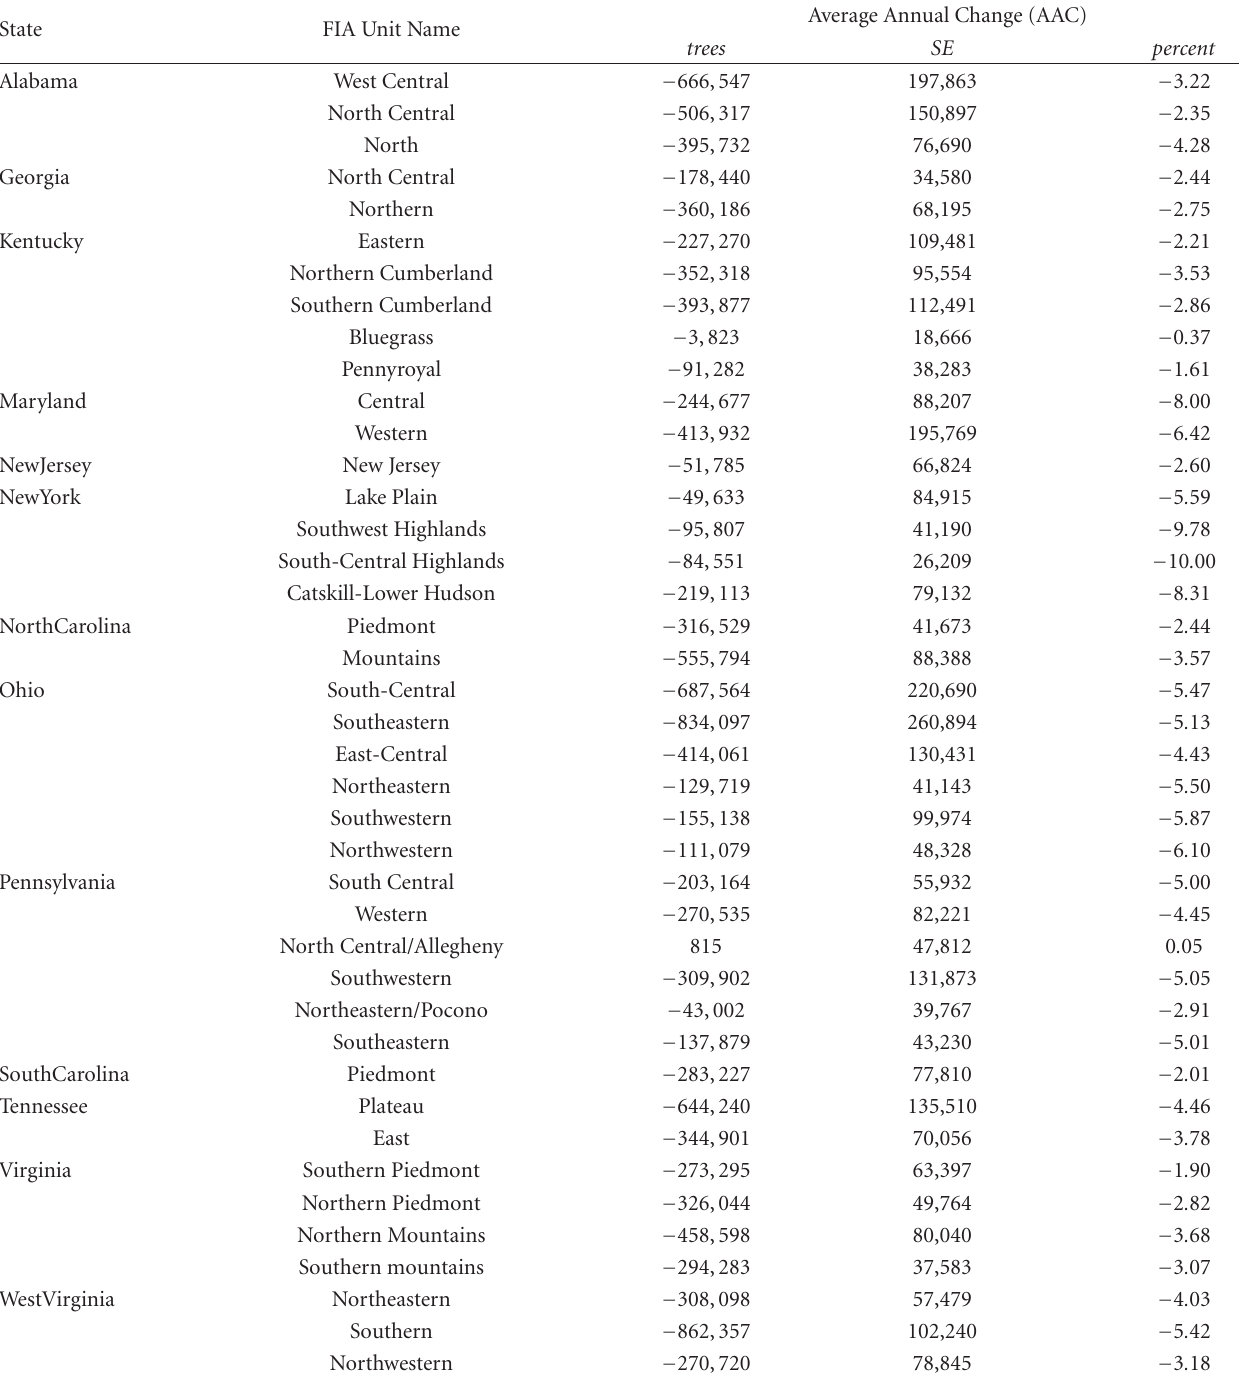
Table 2: Average annual county-level change (AAC), associated sampling error in number of trees and relative AAC of dogwood trees for each FIA unit in the Appalachian